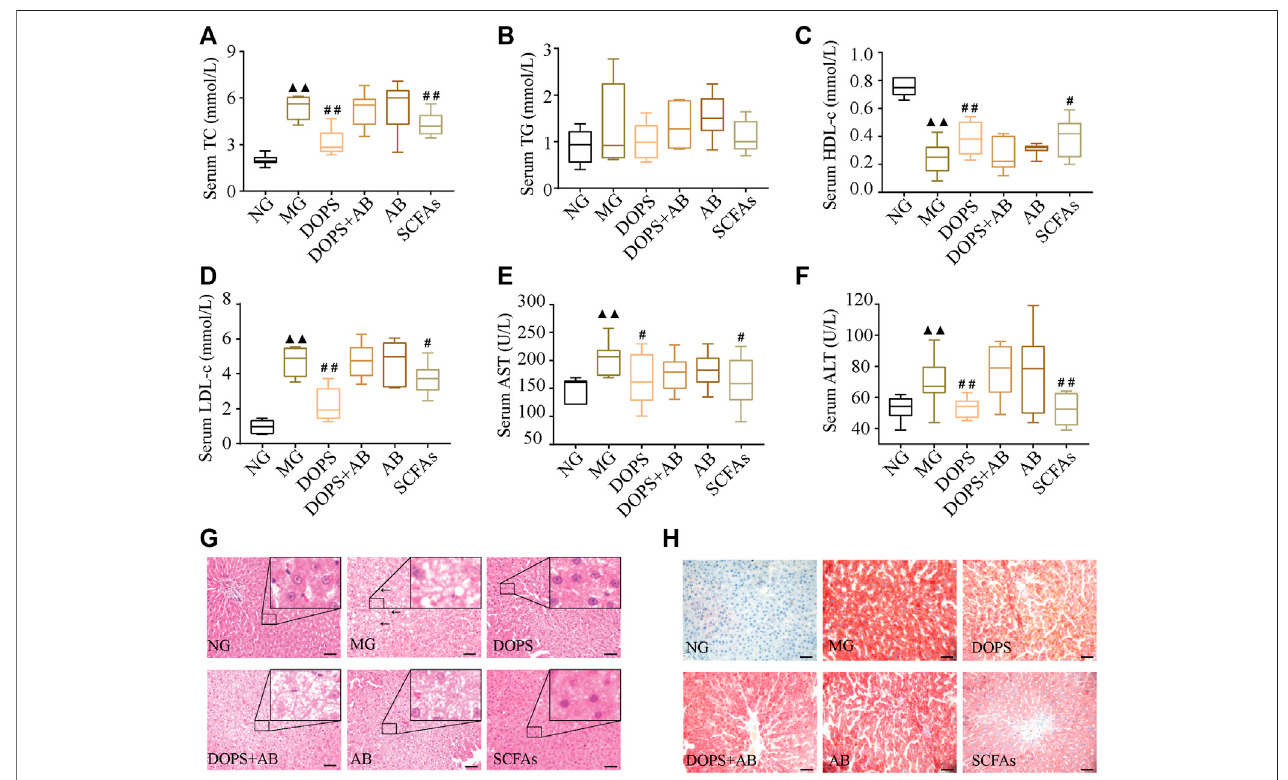
FIGURE 3 | Effect of DOPS on blood lipids and liver function in the MH rats. (A) Changes in serum total cholesterol (TC) after administration. (B) Changes in serum triglyceride (TG) after administration. (C) Changes in serum high-density lipoprotein cholesterol (HDL-c). (D) Changes in serum low-density lipoprotein cholesterol (LDL- c). (E) Changes in serum aspartate transaminase (AST) after administration. (F) Changes in serum alanine transaminase (ALT) after administration. (G) Representative graphsofliverhematoxylinandeosin(H&E)staining(×400). (H) LiverOilRedOstaining(×400)representative graph.Bar=50 μ m. NG,normalcontrolgroup;MG, modelcontrolgroup;DOPS, Dendrobiumof fi cinale polysaccharide;DOPS+AB, Dendrobiumof fi cinale polysaccharide+antibiotics;AB,antibiotics;SCFAs:short-chain fatty acids. The black arrows indicate liver lesions in the model control group. Compared with the normal control group, ▲ p < 0.05 and ▲▲ p < 0.01; compared with the model control group, # p < 0.05 and ## p < 0.01 ( n =